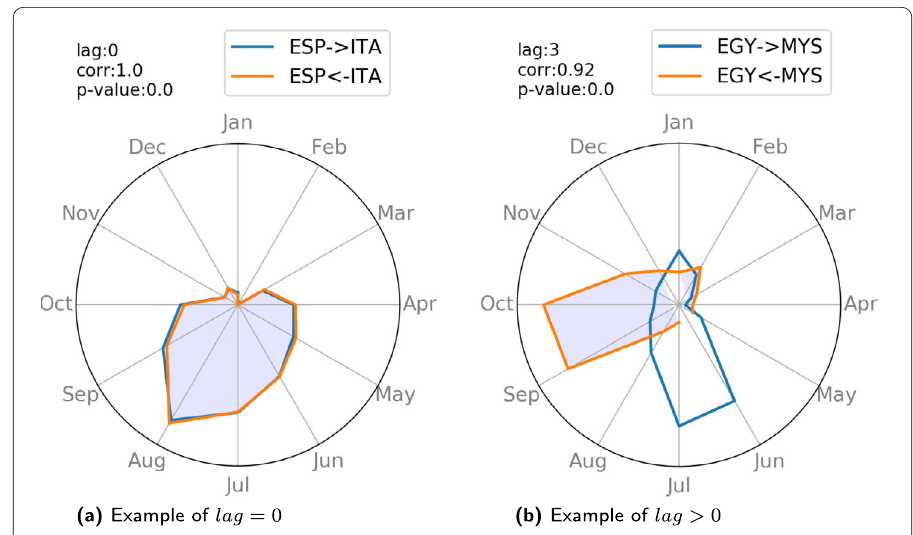
Figure 3 Measuring asynchronicity in mobility between country pairs via cross-correlations. The lag indicates the months needed to best align the incoming and outgoing traffic. Subgraph ( a ) shows an example of perfect alignment without having to shift one relative to the other. Subgraph ( b ) shows an example where a shift of 3 months is needed to best align the two. The lag is a reasonable estimate of the average duration of the